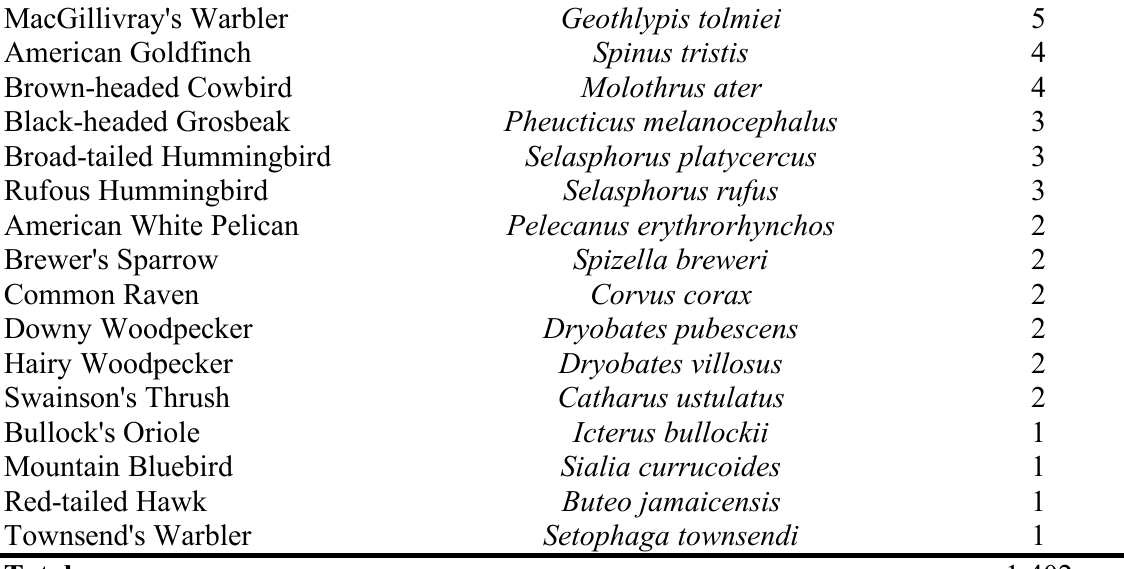
Table S4. Generalized linear mixed model results for all species combined and for individual bird species with >100 observations. Models include daily-averaged L50 and Julian Date as scaled fixed effects and a random effect for site. The conditional variance ( R 2 variance explained by both fixed and random effects. * p <.05, *** p<